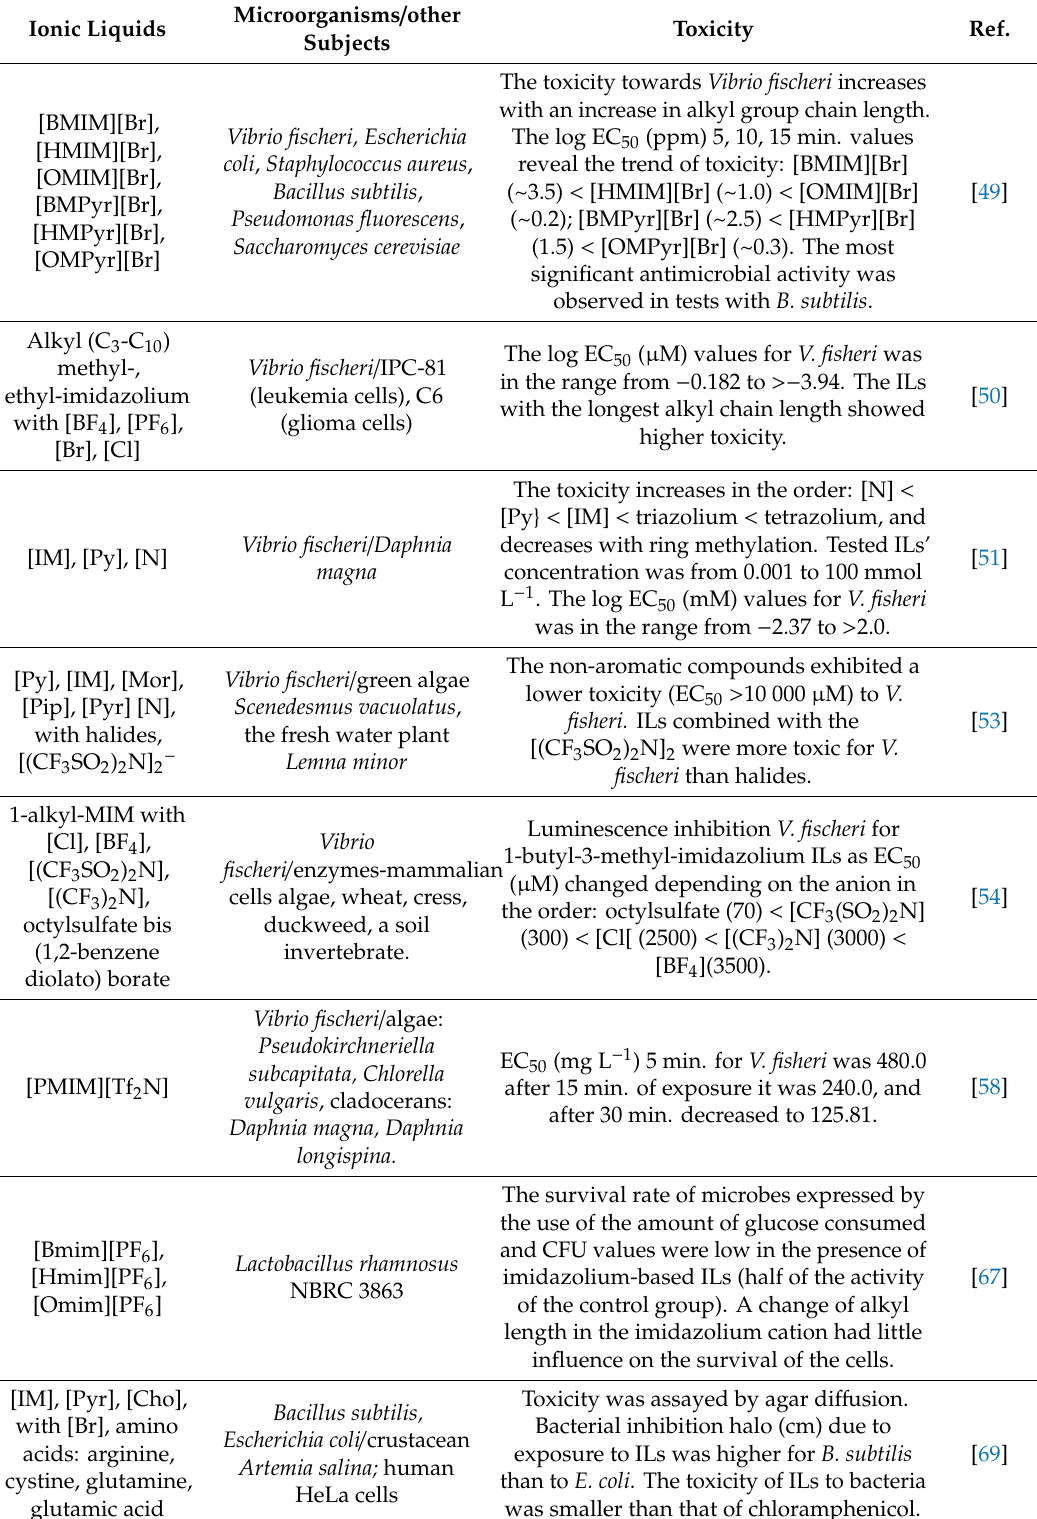
Table 1. Examples of studies on ILs’ toxicity against